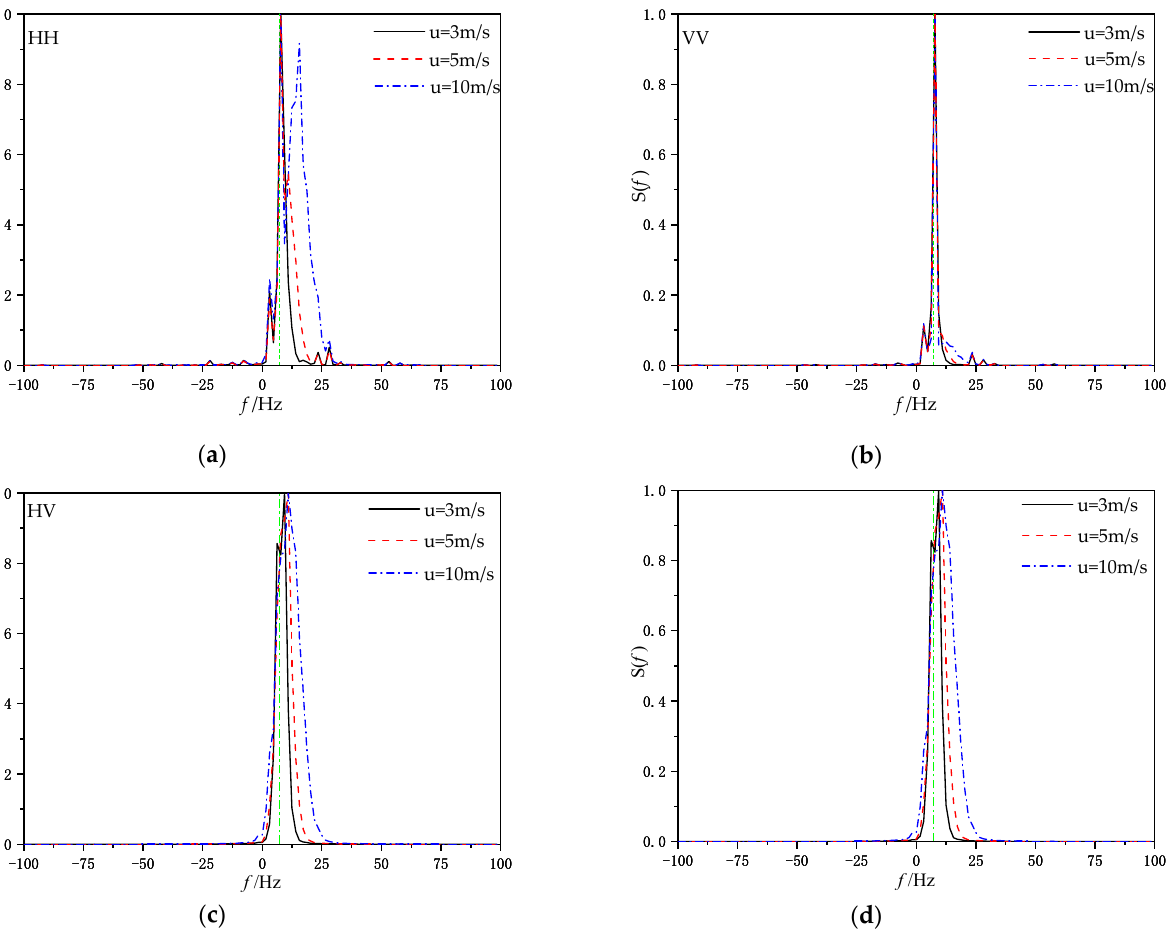
Figure 13. Doppler spectra at different wind speeds for ( a ) Doppler spectrum at HH polarization, ( b ) Doppler spectrum at VV polarization. ( c ) Doppler spectrum at HV polarization, and ( d ) Doppler spectrum at VH polarization.